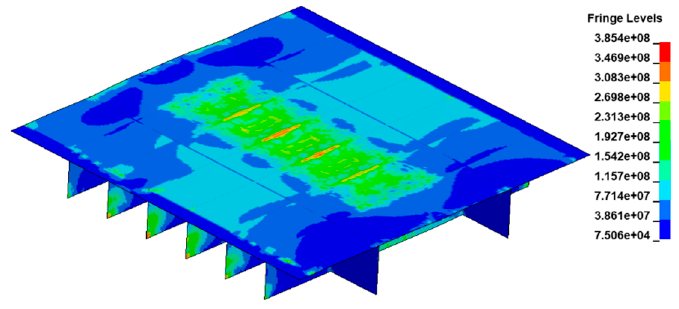
Figure 18. Stress contours of the stiffened plate.